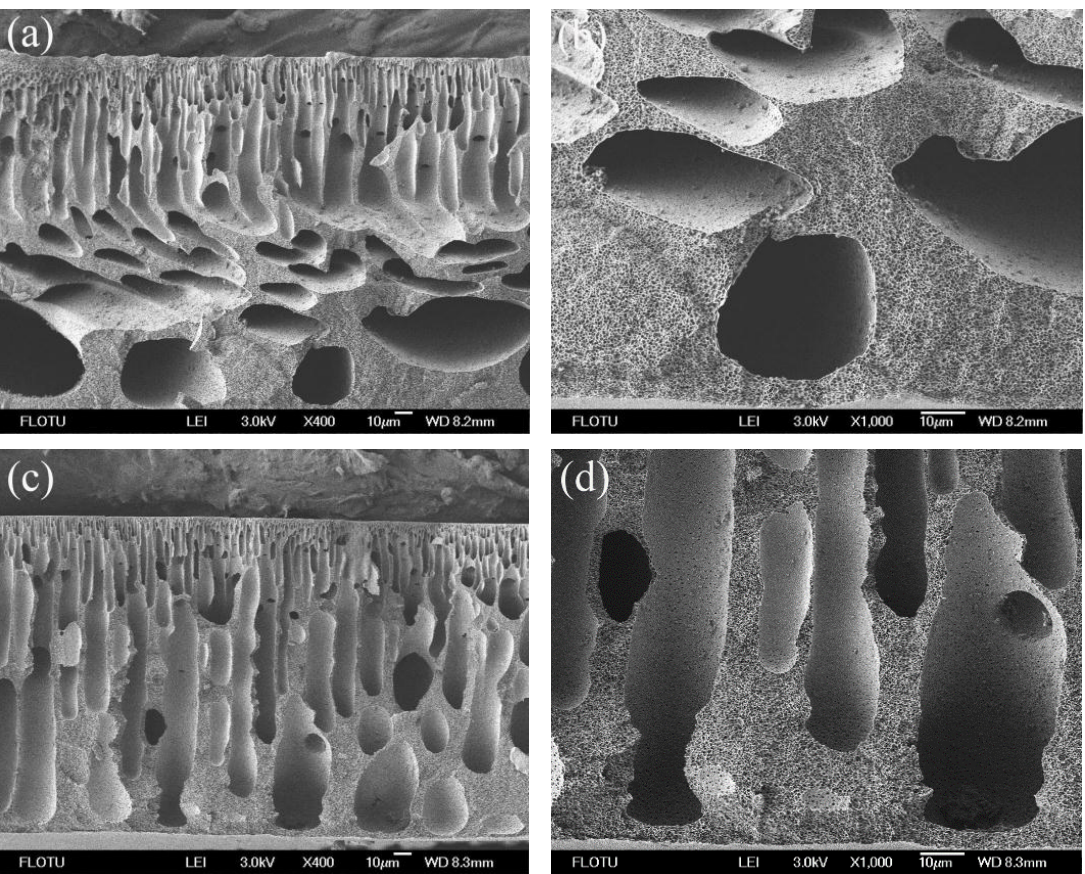
Figure 5. SEM photomicrographs of cross-section of PPSU UF membranes prepared by single and compound additives with PVP as a polymeric pore-forming agent: ( a , b ) PPSU2; ( c , d ) PPSU3; ( e , f ) PPSU4.